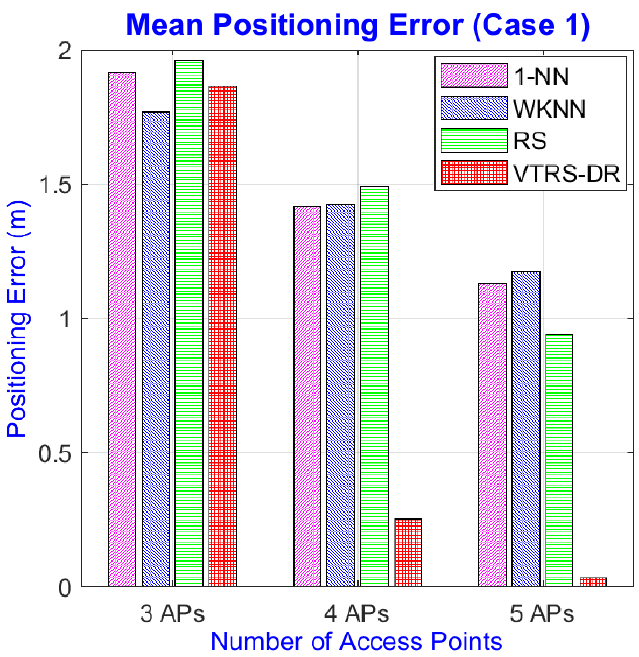
Figure 8. Mean of mean errors of four methods with different numbers of APs in Case 1.